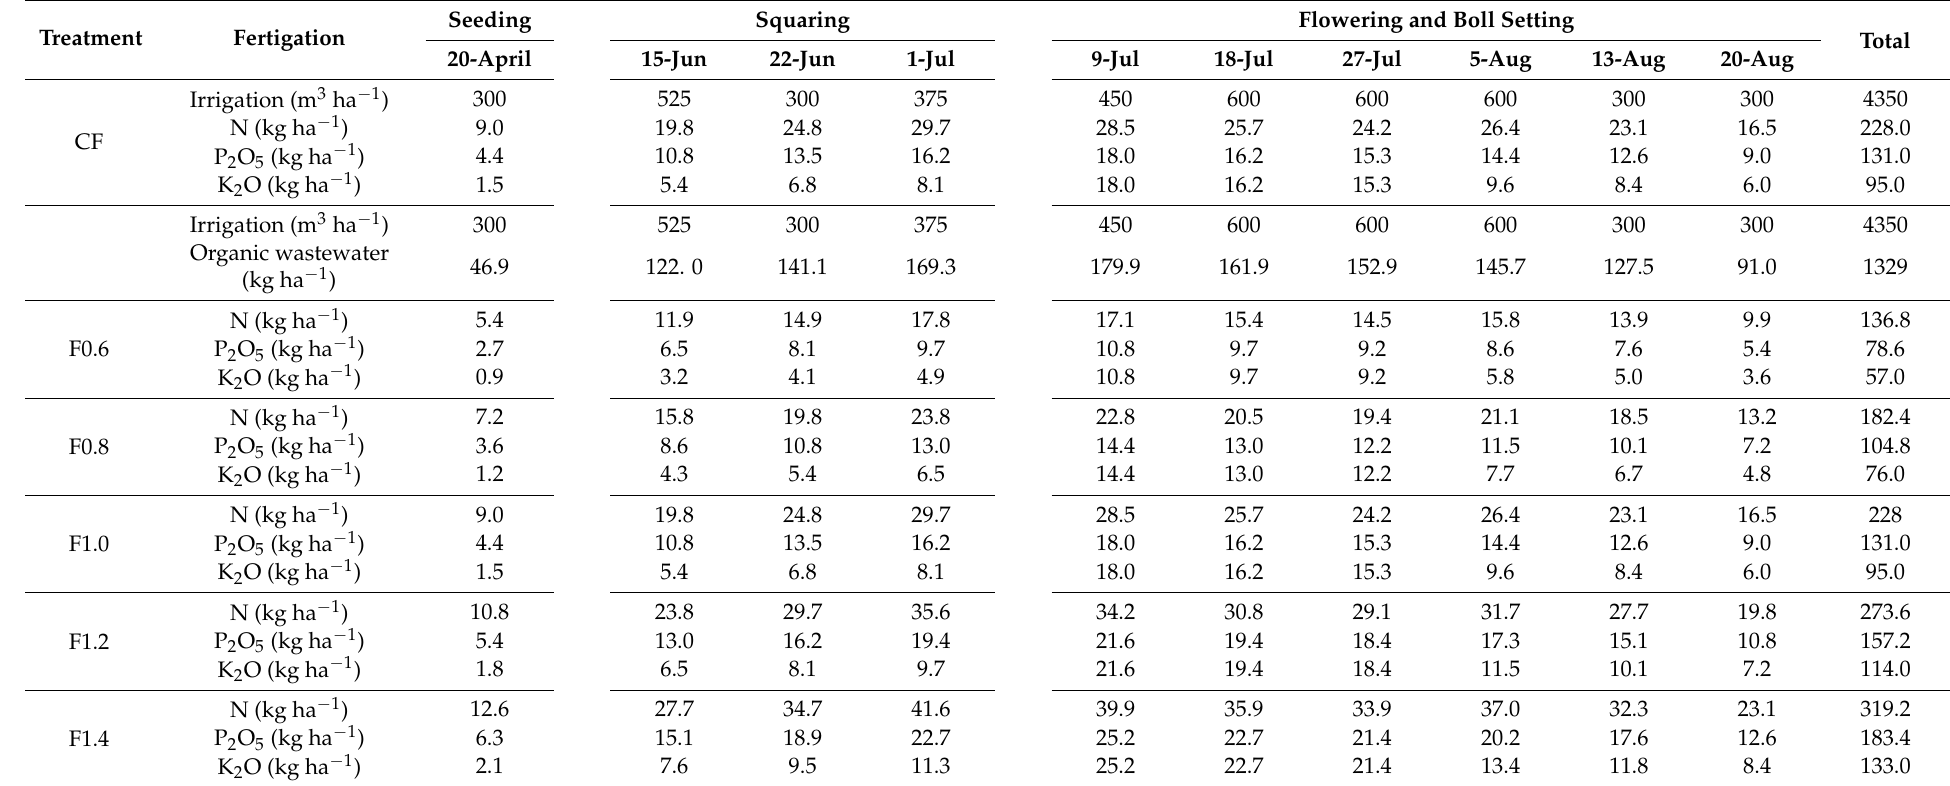
Table 1. Fertilization schemes for different treatments.